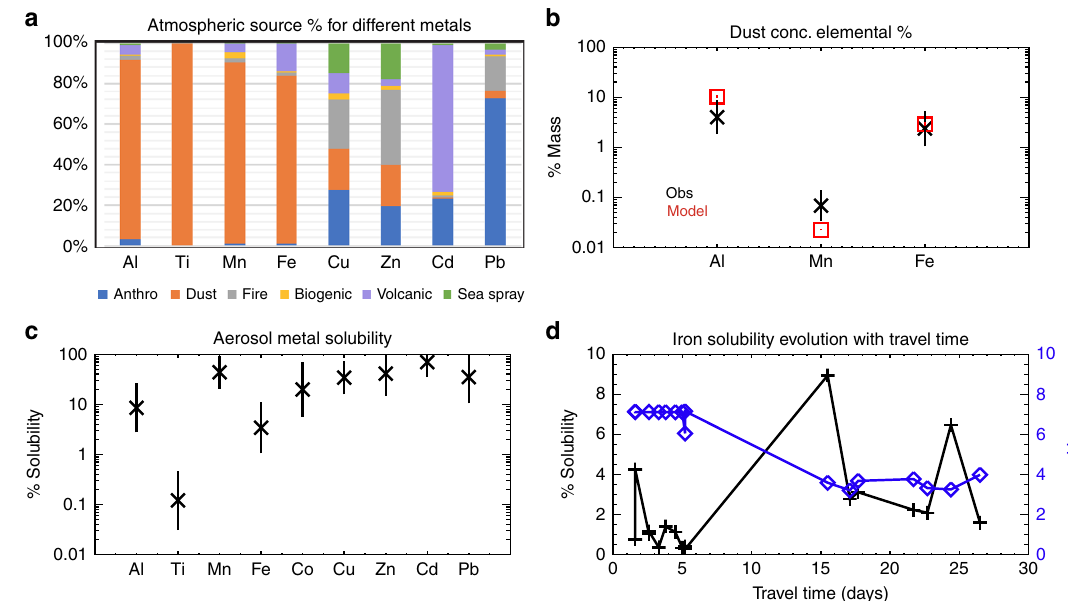
Fig. 3 Variations in aerosol metal composition, solubility, and evolution. a Estimates of the percent of the atmospheric source for different metals; b estimates of the mass percentage of different metals in dust concentrations, from observations and model simulations in dust storm events (from ref. 35 ). c Measurements of metal solubility from ocean cruises with standard deviations shown as error bars 12,36 . d Measurements of iron solubility and pH (blue) as a function of travel time from the source region from ocean cruise (data taken from ref. 44 )